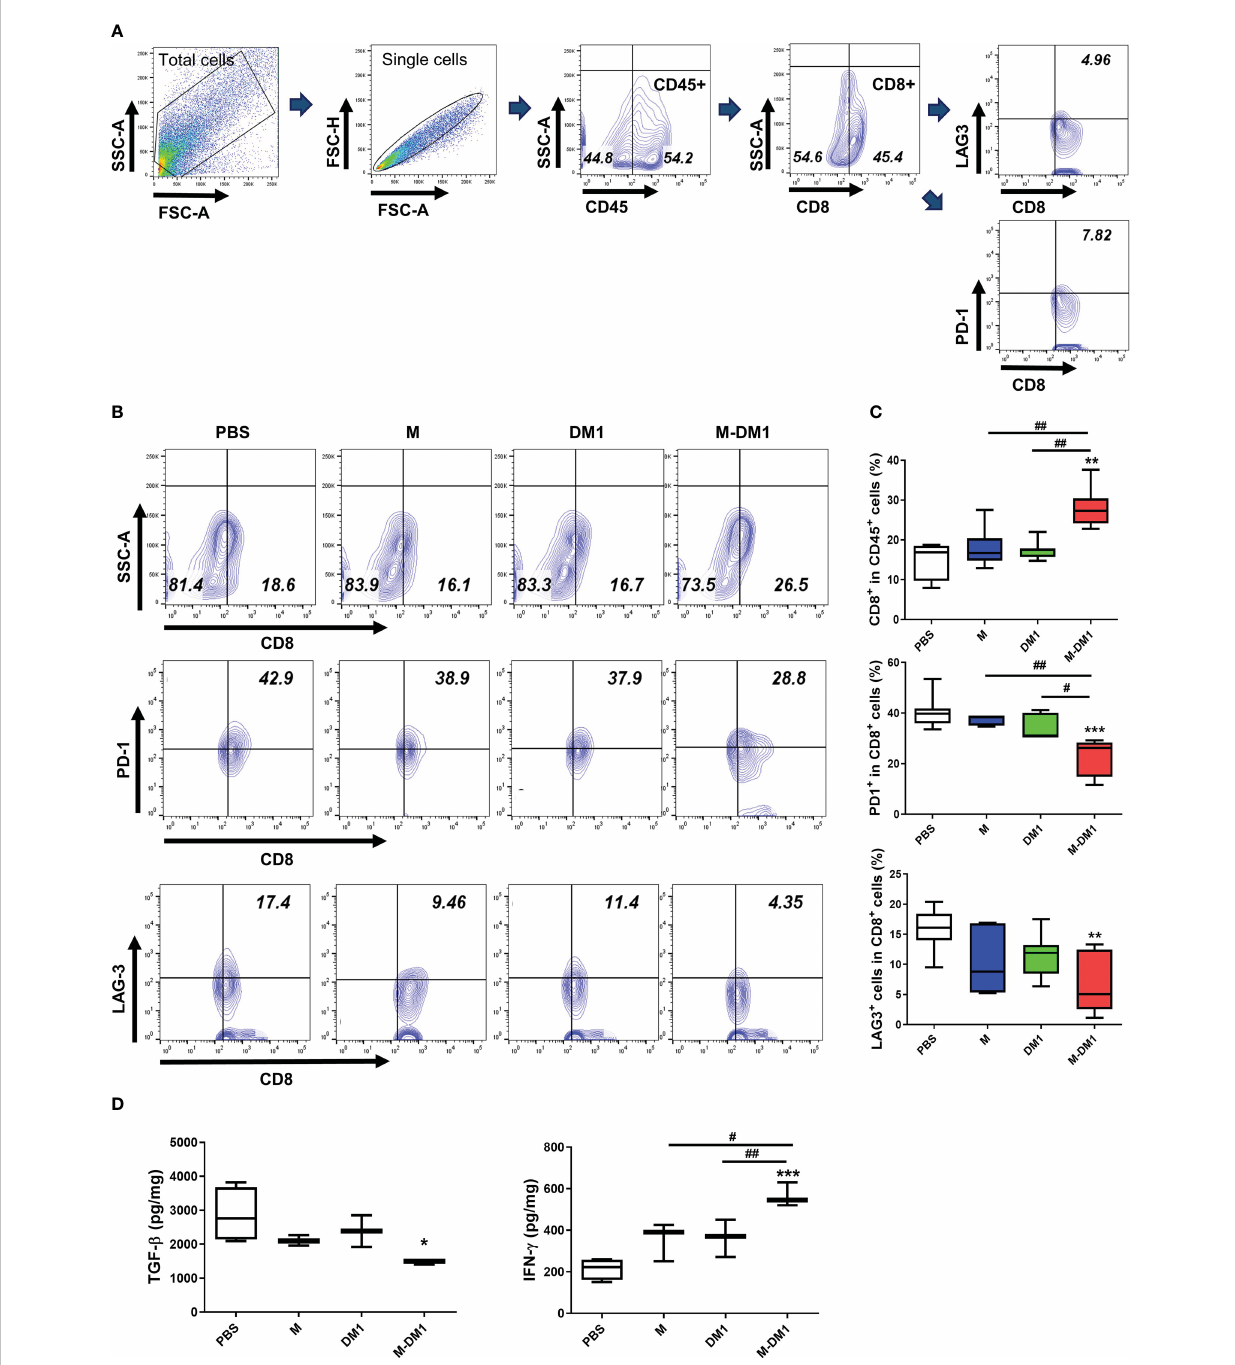
FIGURE 7 M-DM1 treatment effectively regulates the activity of in fi ltrated cytotoxic T cells and downregulates T cell exhaustion. Cells were isolated from tumor tissues. (A) The gating strategies of T cells. (B) CD8+ T cells were stained with CD45 and CD8 (upper panel), and T cell exhaustion markers, PD-1 and LAG-3, as CD45 + CD8 + PD-1 + or CD45 + CD8 + LAG-3 + (middle and bottom panels, respectively). Cells are shown as contour within the CD8 + and PD-1 + or LAG-3 + axis gated on CD45 + cells ( n = 7). (C) Data are displayed as the percentages of CD8 + (upper), PD-1 + CD8 + (middle) and LAG-3 + CD8 + cells (bottom) in the CD45 + cell population. (D) Cytokine (TGF- b and IFN- g ) analysis was con fi rmed by ELISA. Proteins were harvested from tumor tissues by RIPA buffer. All data are presented as the mean ± SD. One-way ANOVA followed by Tukey ’ s post-hoc test was performed for group comparisons; *p < 0.05, **p <0.01, ***p<0.001 vs PBS group; #p < 0.05, ##p < 0.01 vs M or DM1